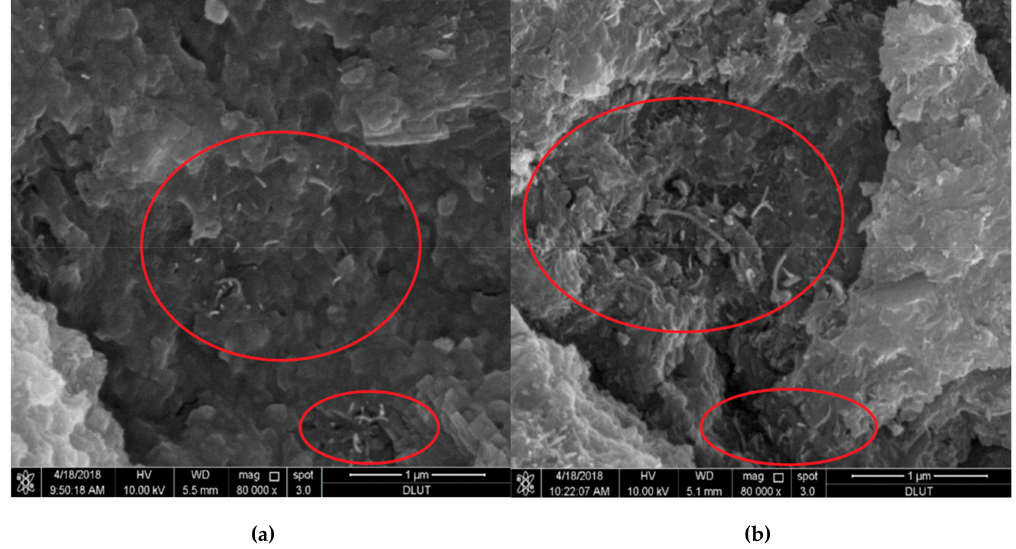
Figure 24. ( a , b ) SEM images of the extensive distribution of MWCNTs in RPC. Reprinted with permission from [118]. Copyright © 2018, Elsevier